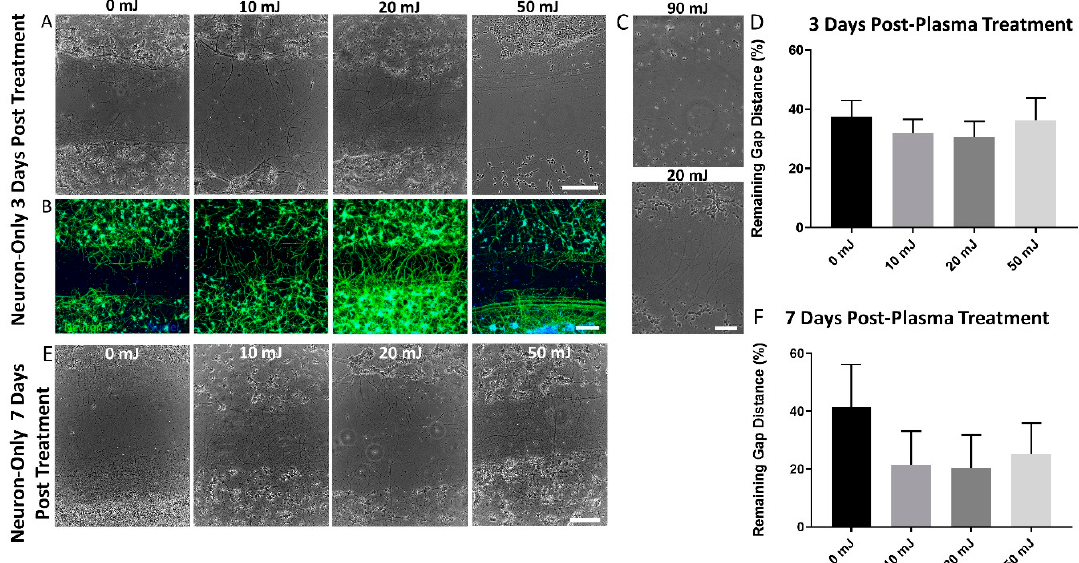
Figure 3. Plasma treatment of neuronal cultures alone did not affect neurite outgrowth into the gap area. ( A ) Phase/Contrast images showing neurite infiltration into the gap area at three days post-treatment (6 DIV) when treated with 0, 10, 20, and 50 mJ plasma. Scale: 250 μ m. While a trend towards increased neurite outgrowth was observed with treatment of 20 mJ plasma, no statistical significance is seen due to plasma treatment. ( B ) Confocal reconstruction of plasma-treated cultures labeled positively for the neuronal marker, b-tubulin III ( green ) and nuclear counterstain, HOECHST ( blue ) three days post-treatment. Qualitative assessment of cultures indicates that neurons and extending neurites remained healthy three days post-treatment when treated with ≤ 50 mJ plasma. Scale: 150 μ m. ( C ) Higher magnification phase-contrast images clearly showing the difference between cultures where plasma treatment reduced neurite outgrowth (90 mJ treatment) and cultures where plasma treatment increased neurite outgrowth (20 mJ treatment). Scale: 100 μ m ( D ) Quantification of neurite outgrowth at three days post-treatment (6 DIV). No significant difference in neurite outgrowth was observed when compared to control, untreated groups. ( E ) Phase-contrast images of neuron-only cultures seven days post plasma treatment with 0, 10, 20, and 50 mJ plasma. Scale: 250 μ m. ( F ) Quantification of neurite outgrowth at seven days post-treatment (10 DIV). No significant neurite outgrowth was observed when compared to untreated groups. ( D , F ) Bars represent SEM.